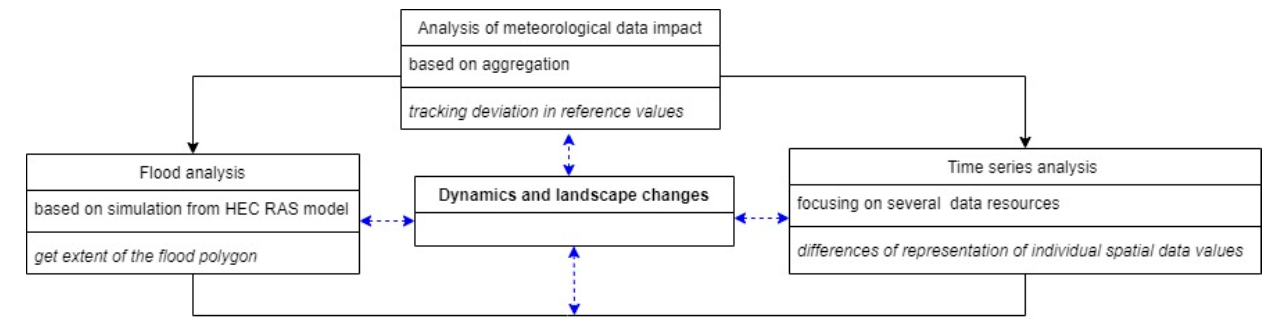
Figure 5. Methodological flow chart.